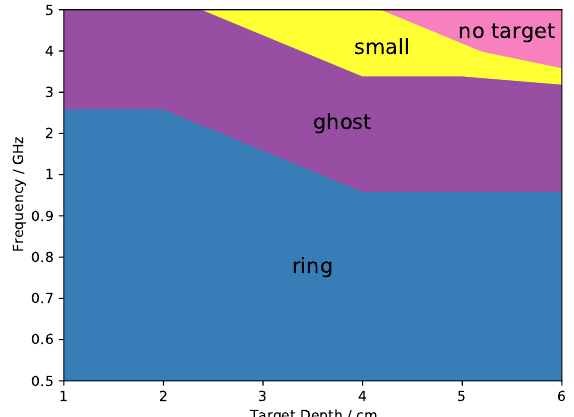
Figure 7. General distribution of the artifacts relatively to central frequency and target depth. There are several reasons behind the artifacts. The rings of Figure 5 were given by the strong interaction between the central antennas and the target. In fact the distance